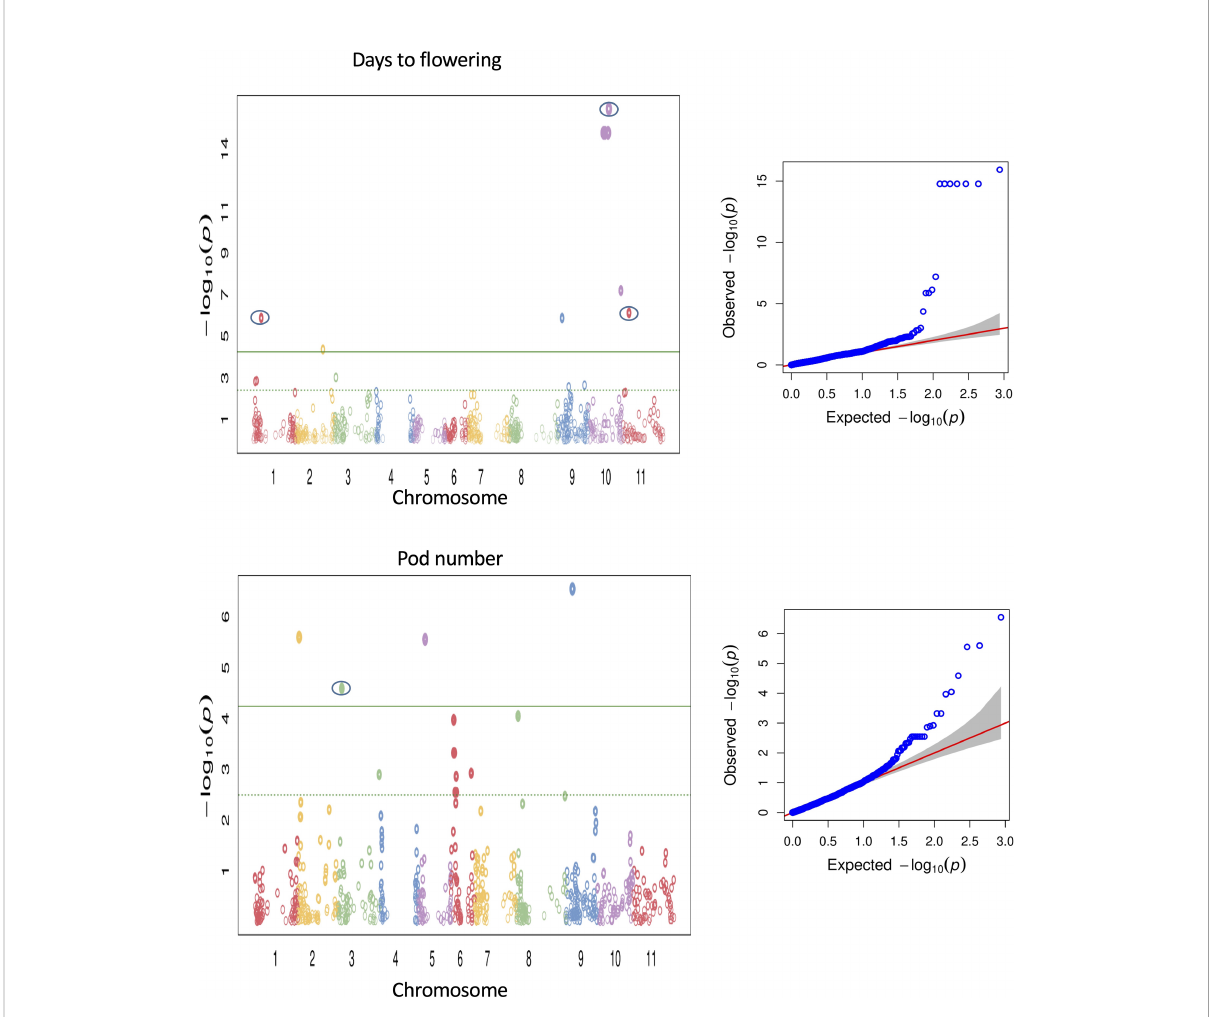
FIGURE 5 Manhattan and QQ plots for GWAS using FarmCPU for fl owering time and pod number. The green line is the FDR cutoff value to call a signi fi cant peak. Peaks enclosed in circles indicate SNPs associated with QTL overlapping with previously reported